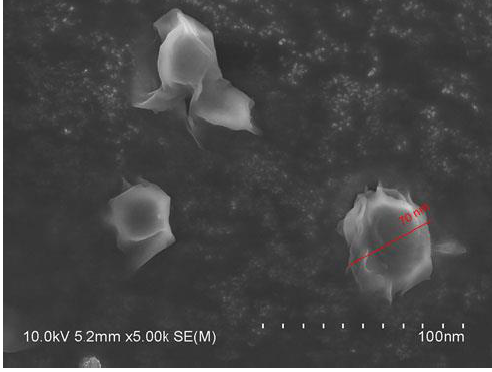
Figure 1. SEM micrograph of SLCN.